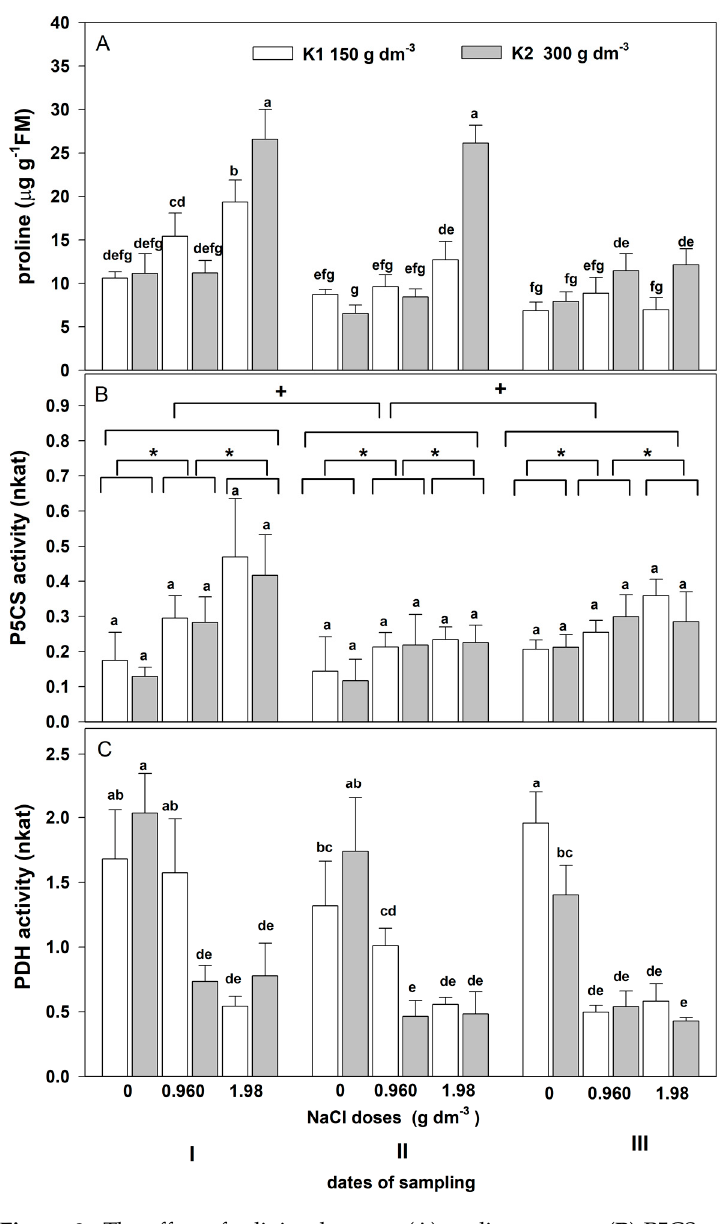
Figure 8. The effect of salinity doses on ( A ) proline content, ( B ) P5CS activity, and ( C ) PDH in the leaves of zinnia grown in the peat substrate with two doses of potassium. In figures ( A ) and ( C ), different letters show significant effects of NaCl and K doses and sampling dates. In figure ( B ), letter “a” shows the lack of a significant effect of the K + level, an asterisk (*) shows a significant effect of salt doses, and + shows a significant effect of the sampling dates (I, II, III). Values are expressed as the means (n = 5) ± standard deviation.